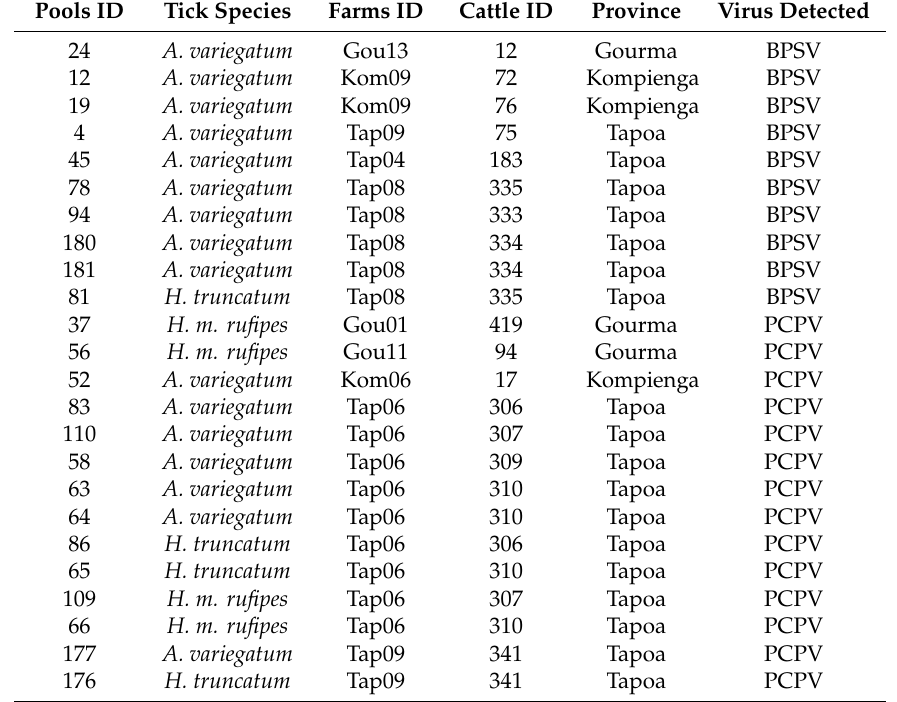
Table 4. Positive tick species pools for bovine papular stomatitis virus (BPSV) and pseudocowpox virus